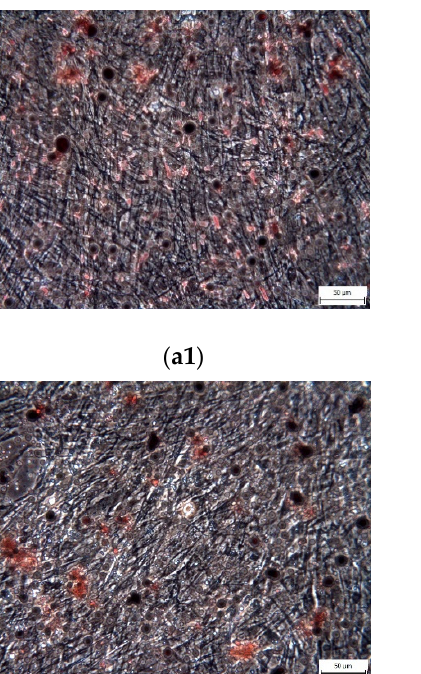
Figure 10. The histological detection of calcium phosphate deposits in the extracellular matrix of paired DPSC lineages after osteogenesis. Deposits are observed as black/brown spots. Scale bar 50 μ m. ( a ) Lineage 5-A; ( b ) Lineage 5-B.